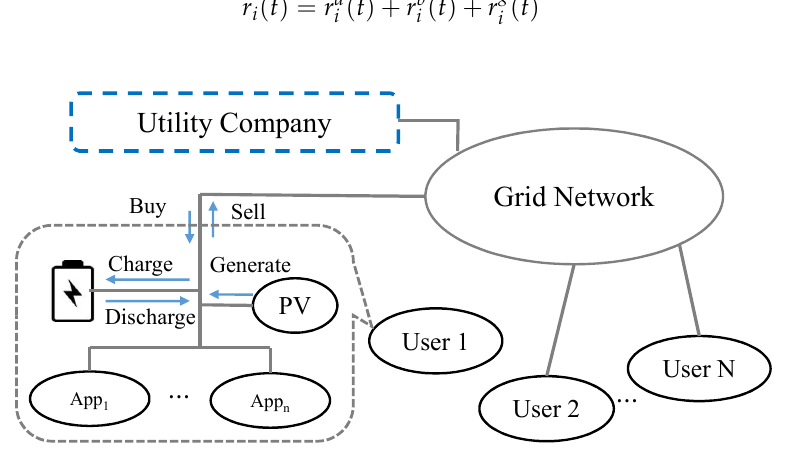
Figure 2. An illustraton of the system model